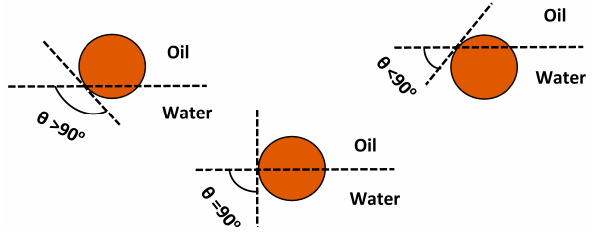
Figure 2. Different wetting conditions described in terms of contact angle θ .